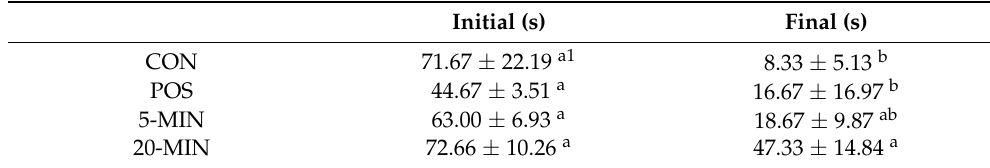
Table 3. Forced swimming test during the initial and final periods. CON: chronic stress-exposed control group; POS: linalool (positive control) inhalation with chronic stress-exposed rats; 5 MIN: BEO inhalation for 5 min by chronic stress-exposed rats; 20 MIN: BEO inhalation for 20 min by chronic stress-exposed